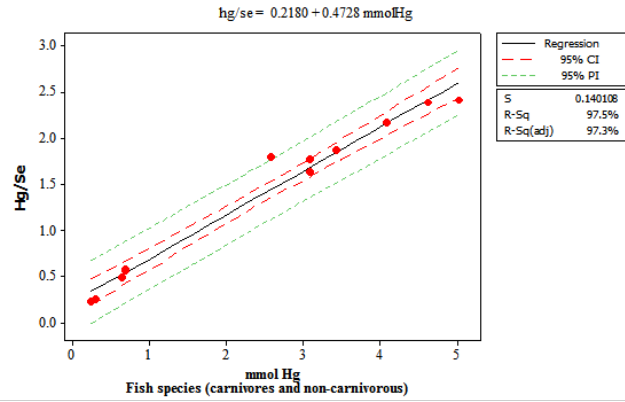
Figure 6: Molar ratio Hg/Se and Hg millimole in fish species (Carnivorous and